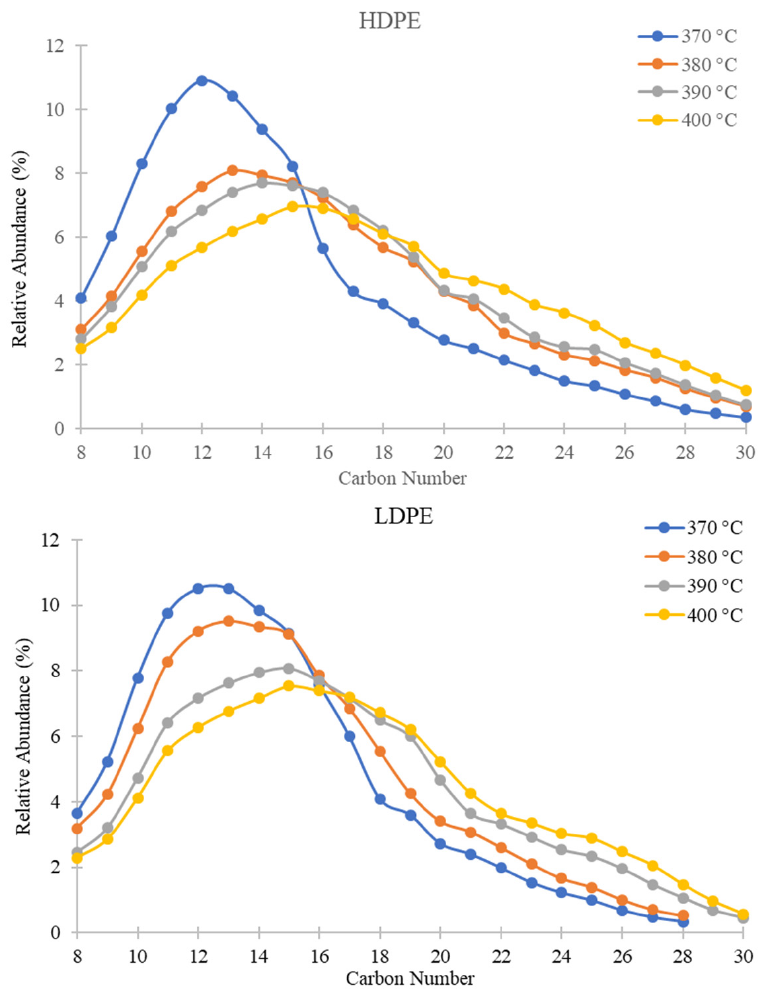
Figure 4. Relative abundances of C 8 –C 30 hydrocarbons for PDFO as a function of temperature for HDPE waste ( top ) and LDPE waste ( bottom ) as determined from GC-MS analysis. Table 1. Summary of predominant hydrocarbons in PDFO as a function of temperature and plastic type.